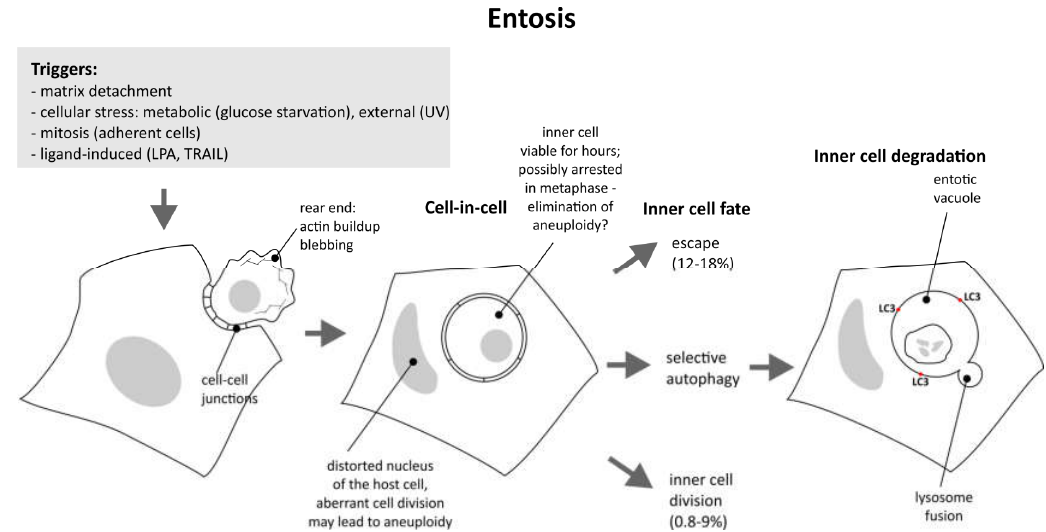
Figure 1. Entosis from initiation to completion; various triggers induce cytoskeletal changes, resulting in the formation of cell-in-cell structure. Both internal and external cells are prone to aneuploidy. Viable internal cells may still escape or divide, but the majority are destroyed by autophagy and lysosome